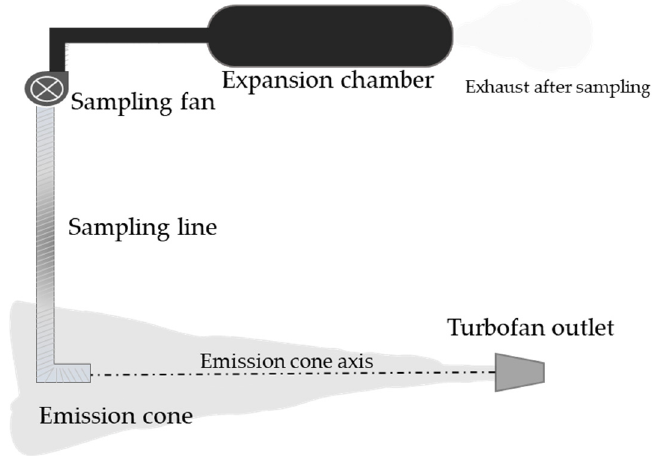
Figure 1. Schematic representation of the sampling line adopted to characterize the emissions from the Spey Mk 202 engine. The sampling inlet was placed in line with the axis of the exhaust emission cone. The suction of the emissions was performed by a sampling fan allowing a quasi-isokinetic sampling. The turbofan exhaust was then allowed to expand into an expansion chamber where instrument sampling lines were placed. The non-sampled exhaust was left to exit the expansion chamber during the whole sampling period.